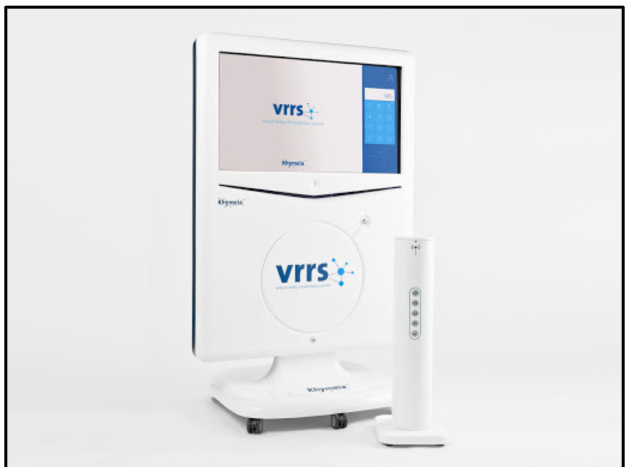
Figure 1. The Virtual Reality Rehabilitation System (VRRS ® ).